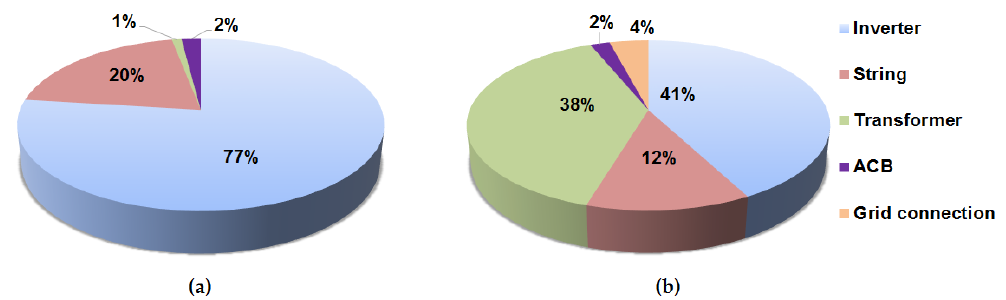
Figure 9. Occurrences of failures per subsystem ( a ) share of total losses divided ( b ) per subsystem for the string inverter scenario.